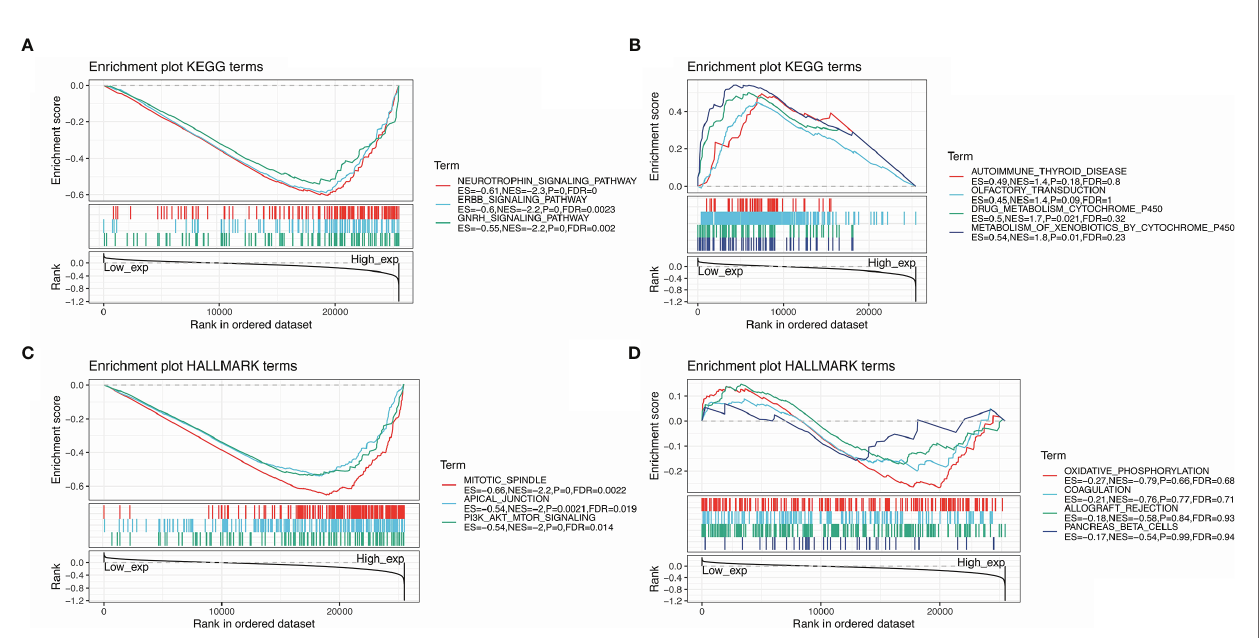
FIGURE 10 | GSEA for samples with high SMARCA4 expression and low expression. (A) The enriched gene sets in KEGG collection by the high SMARCA4 expression sample. (B) The enriched gene sets in KEGG by samples with low SMARCA4 expression. (C) Enriched gene sets in HALLMARK collection, the immunologic gene sets, by samples of high SMARCA4 expression. (D) Enriched gene sets in HALLMARK by the low SMARCA4 expression. Each line representing one particular gene set with unique color, and upregulated genes located in the left approaching the origin of the coordinates, by contrast the downregulated lay on the right of x -axis. Only gene sets with NOM p < 0.05 and FDR q < 0.06 were considered signi fi cant. Only several leading gene sets were displayed in the